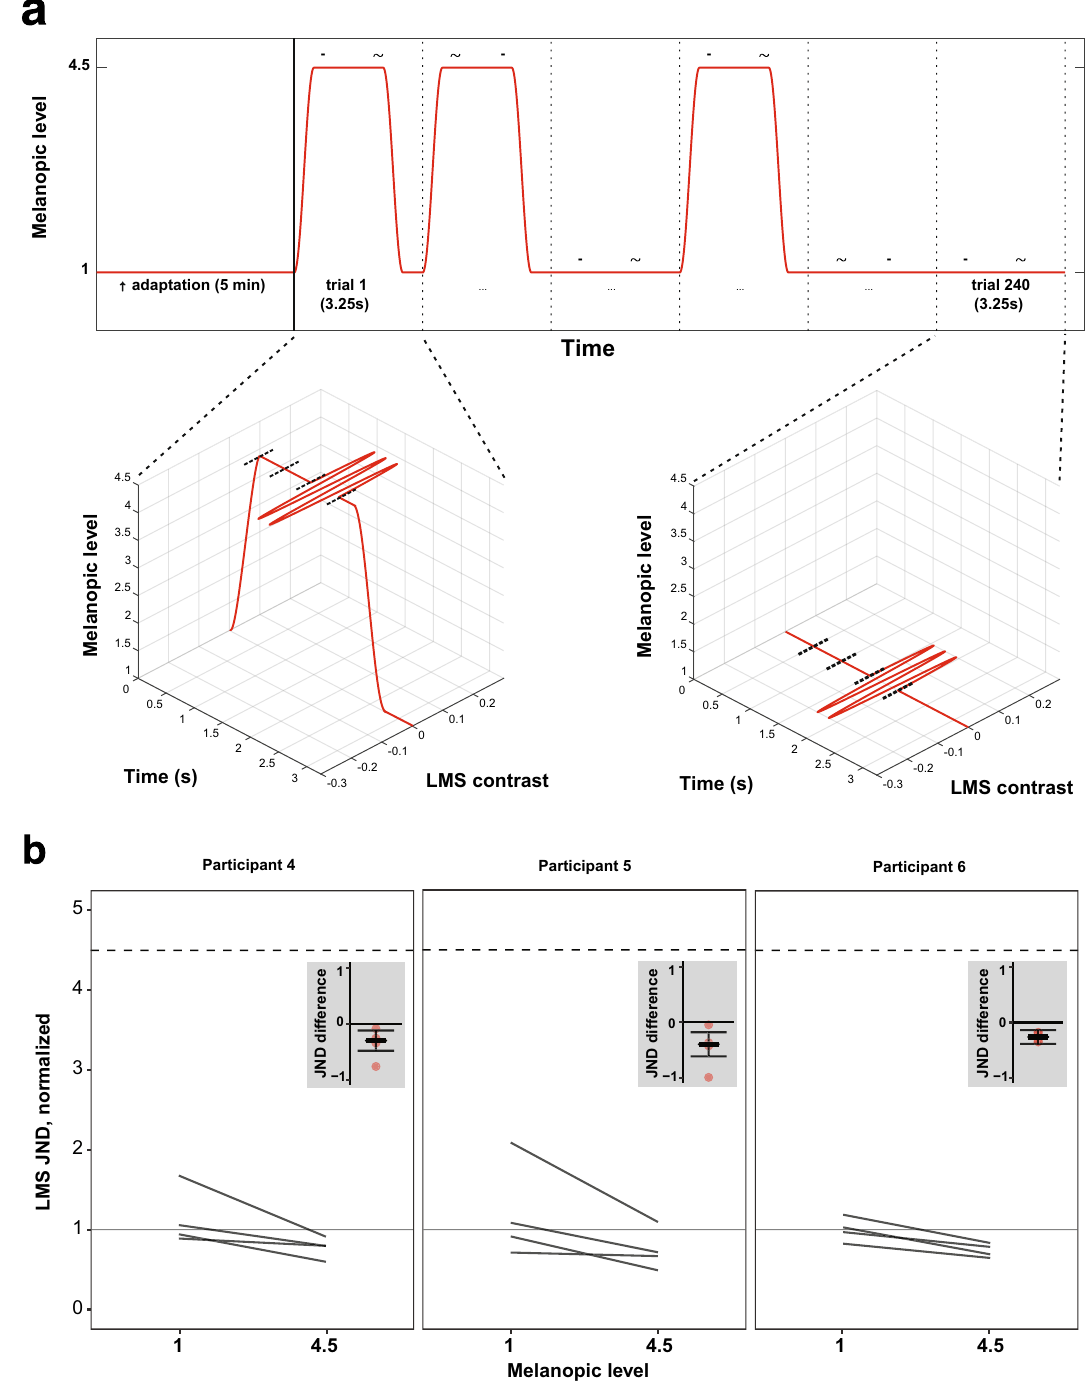
Figure 3. Experiment 2 stimulus and results. ( a ) Temporal structure of trials in Experiments 2 and 3, where the target flicker was presented with or without a melanopsin-directed pedestal. Sessions started with an adaptation period of 5 min to the low-melanopic background. Participants then completed 240 trials of a 2IFC task, half of which contained a pedestal of melanopic stimulation. Individual trials consisted of two 500 ms intervals, separated by a 500 ms ISI. On trials containing the pedestal, melanopic stimulation rose during a 250 ms cosine window, and stayed high for the two intervals and ISI. During either the first or second interval, sinusoidal flicker directed at the L, M, and S cones was presented around the melanopic pedestal; on the other interval no such flicker was presented. After both intervals were presented, melanopic stimulation ramped back down to the low-melanopic background during another 250 ms cosine window, after which the participant was asked to indicate which of the two intervals contained the flicker—this response was untimed. On trials without the melanopic pedestal, melanopic stimulation stayed at the low-melanopic background level for the duration of the trial, including the 500 ms preceding the first interval. Intervals were indicated with an auditory cue. Participants could take a variable-length break in between blocks. Trial order was pseudorandom. ( b ) Experiment 2 results. Same format as Fig.